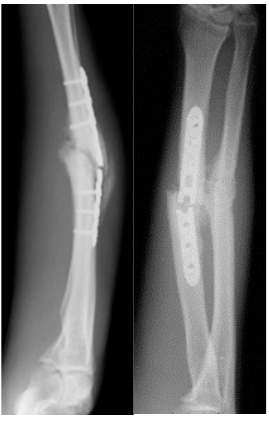
Figure 2. A 38 ‐ year ‐ old patient presented a hypertrophic symptomatic nonunion with a broken Figure 2. A 38-year-old patient presented a hypertrophic symptomatic nonunion with a broken plate plate after 9 months. after 9